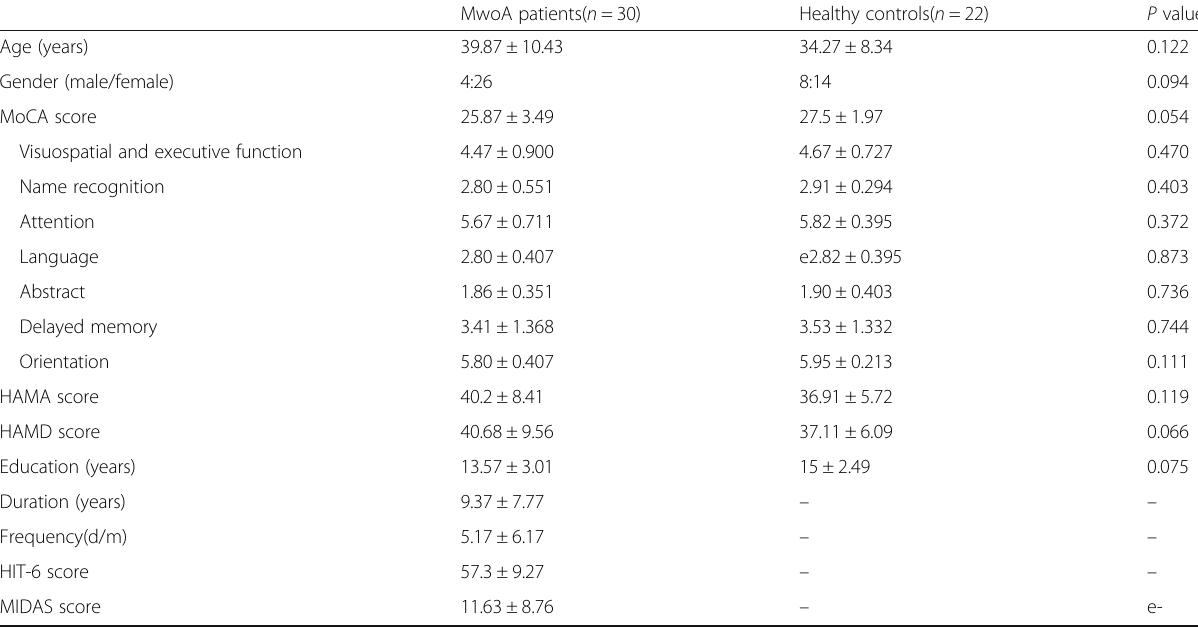
Table 1 Demographic and clinical characteristics of